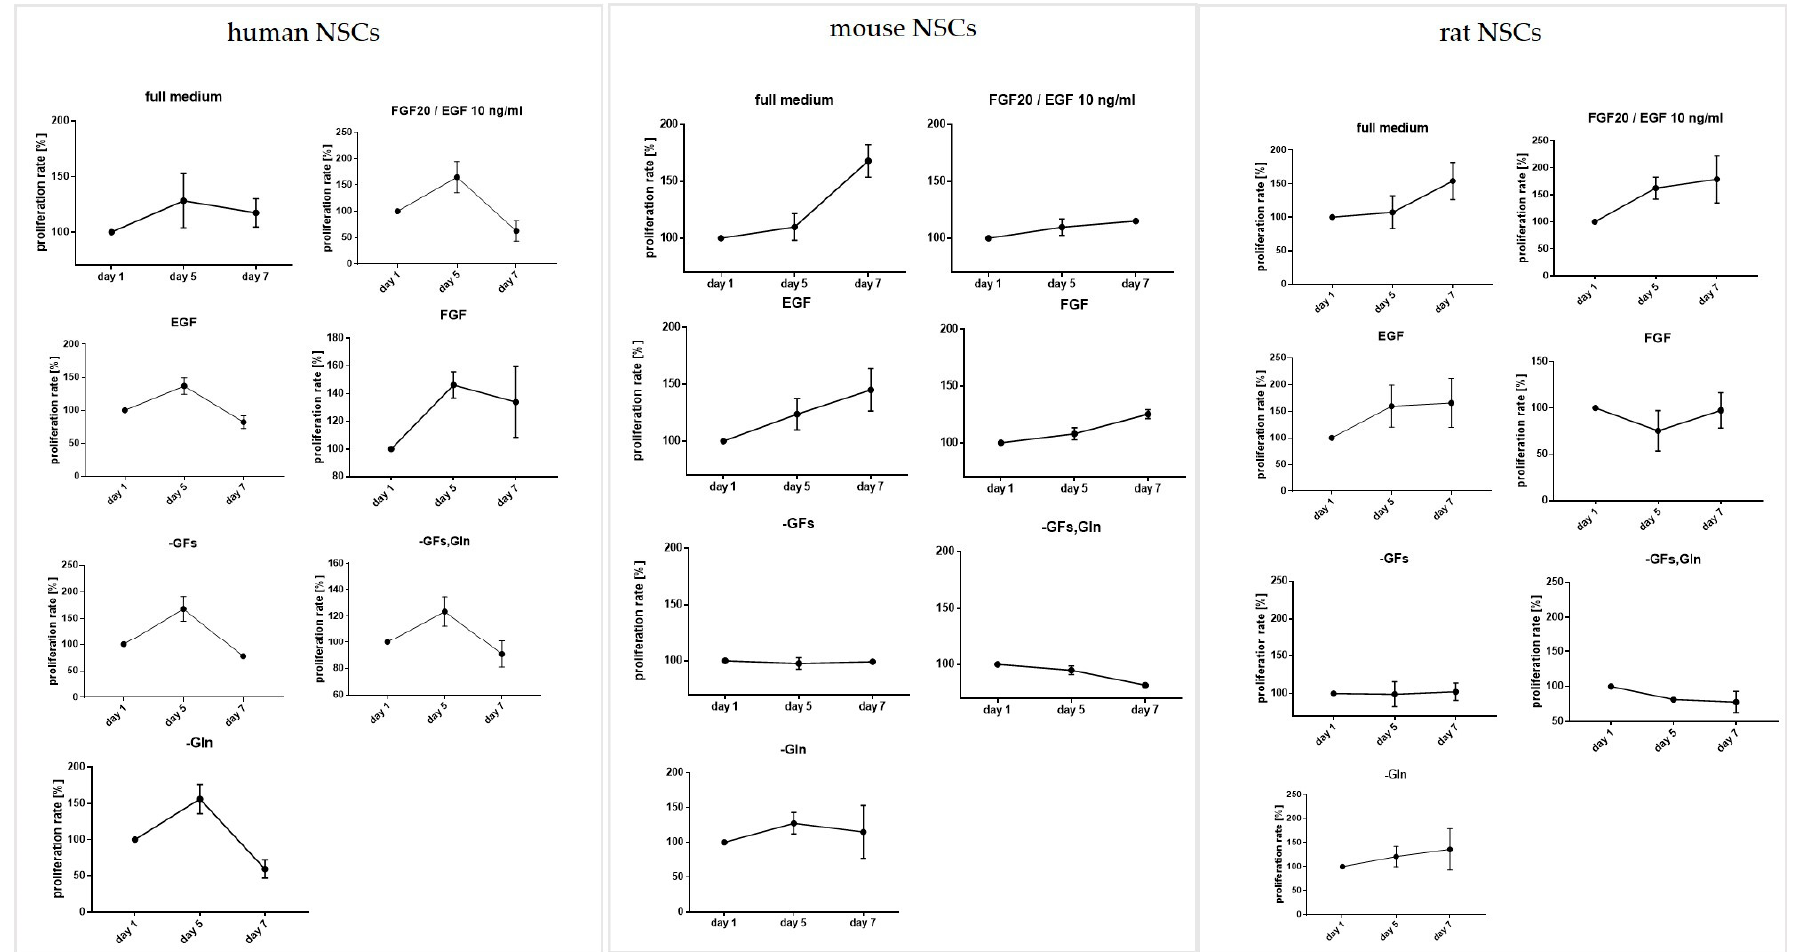
Figure 5. The influence of culture medium composition on the cell proliferation rate on Days 1, 5, and 7 in relation to the cells’ origin. Cell culture conditions: 5% O 2 , 5% CO 2 , 37 °C. N = 3. The results are presented as mean values of three experiments ± SEM.